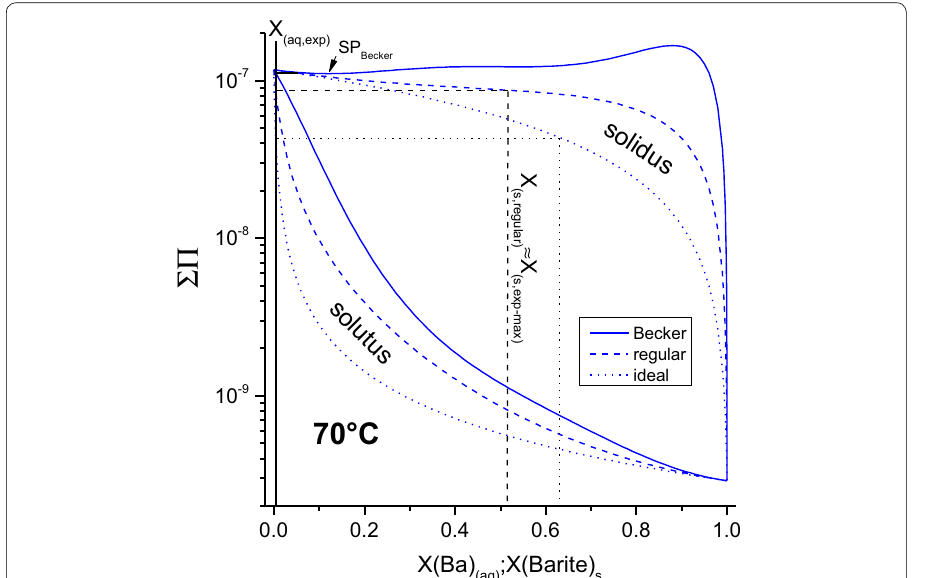
Fig. 6 Lippmann diagram for (Ba,Sr)SO 4 at 70 °C and 1 bar pressure. Highlighted by lines are the composition of the aqueous solution at the geothermal site ( X (aq, exp) the spinodal gap according to the Becker model (SP Becker )